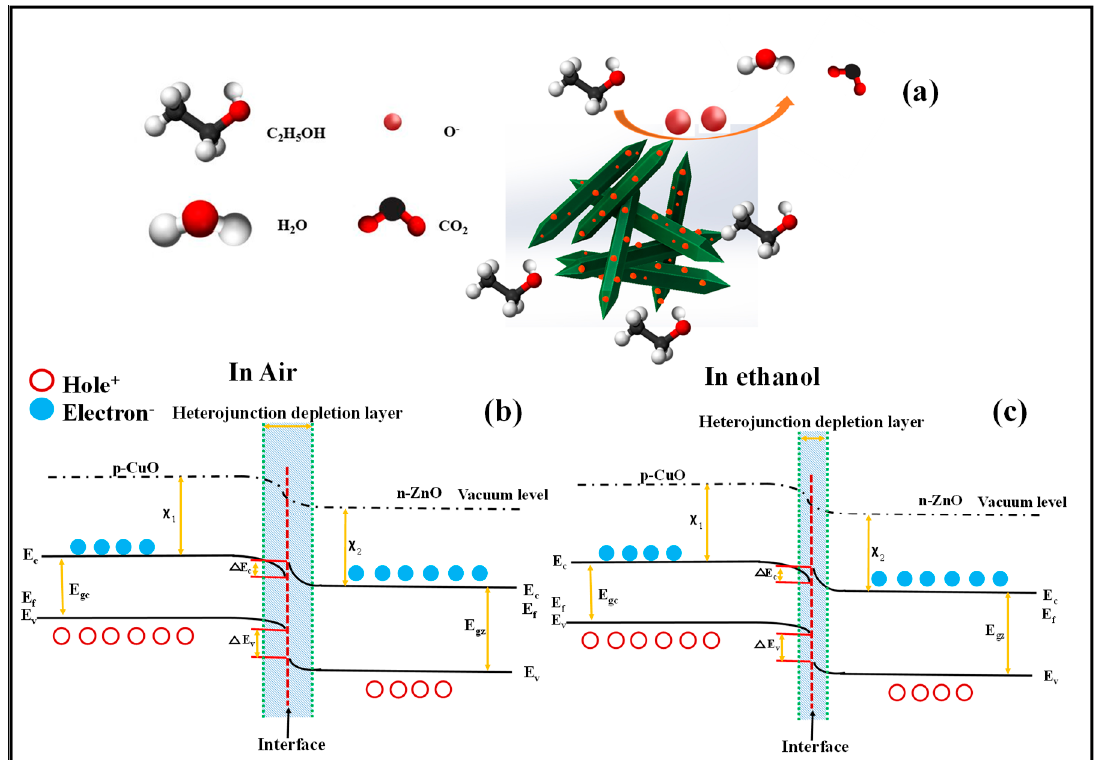
Figure 15. ( a ) Schematic representation of ethanol sensing mechanisms of CuO-decorated ZnO NRs. Ethanol sensing mechanism of CuO-decorated ZnO NRs in ( b ) air and ( c ) in ethanol